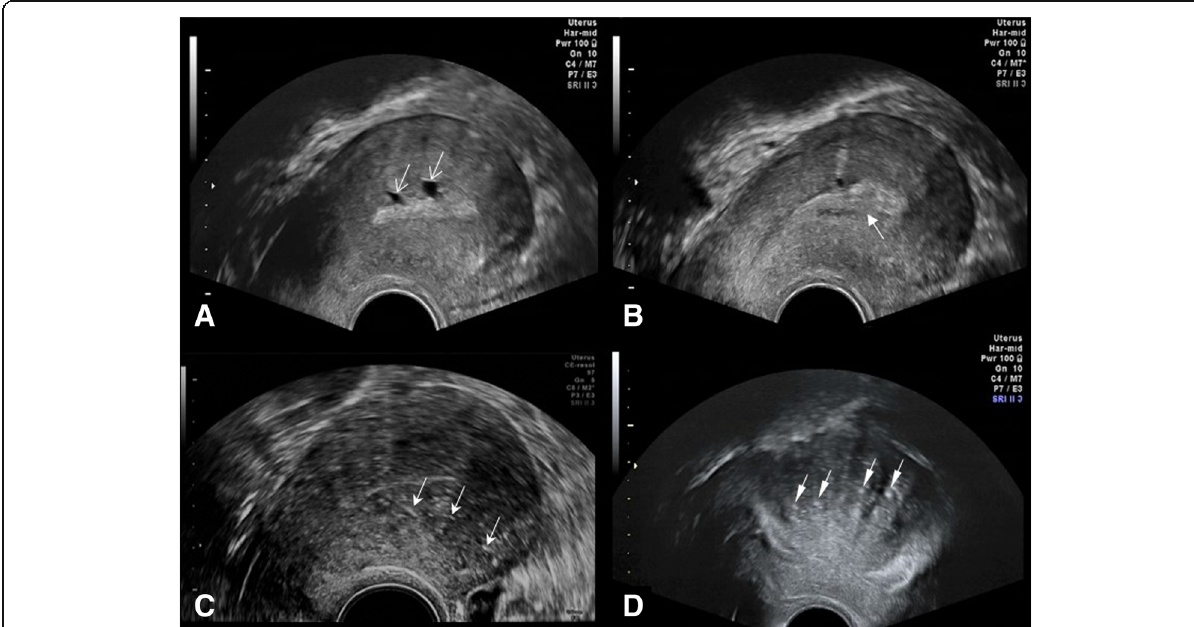
Fig. 1 Direct and indirect imaging features of adenomyosis on ultrasound. a Small posterior wall myometrial cysts (open arrows). b Poorly defined endo-myometrial interface (solid arrow). c Diffuse myometrial heterogeneity with hyperechoic linear striations (three arrows). d Diffuse asymmetric widening of the posterior myometrial wall with hyperechoic nodules (four arrows)